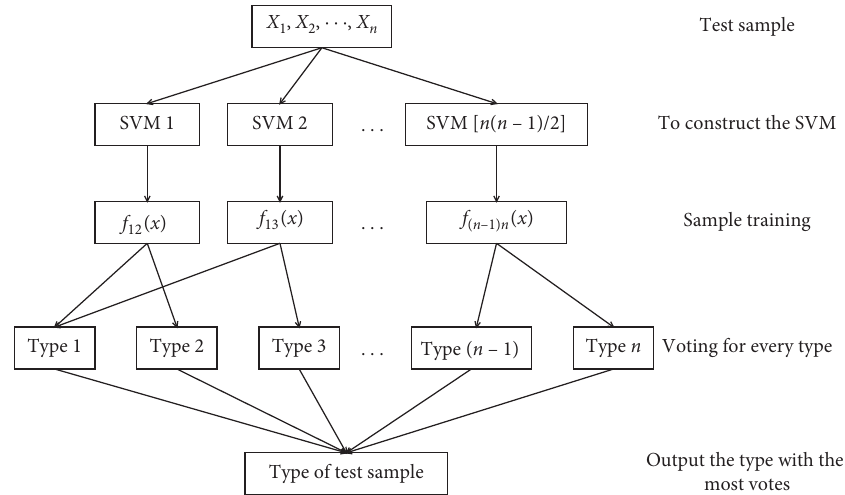
Figure 2: Calculation flow of